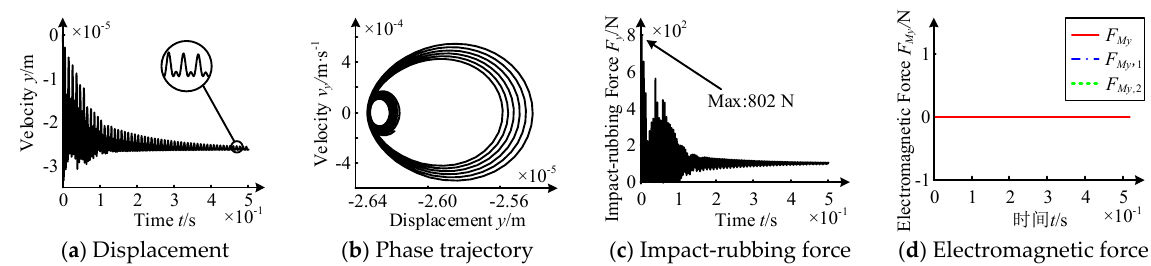
Figure 11. Operating law of the system under the failure of the upper and lower units. According to Figure 11, the bouncing stage mainly occurs within 0.1 s. The rotor displacement, impact-rubbing force, and residual electromagnetic force shake violently, and their amplitudes gradually decrease. The maximum impact-rubbing force is 802 N. The eddy stage mainly occurs after 0.1 s. In this stage, the displacement gradually converges at about − 26 µ m, which indicates the rotor will eventually stagnate at the bottom of the fixed ring. The phase trajectory presents a double-periodic closed circle from the outside to the inside, which indicates that the displacement tends to converge. There is no residual electromagnetic force, and the variation of the impact-rubbing force is similar to that of the displacement, converging at about 100 N, and the vector value is just in balance with the rotor’s gravity.